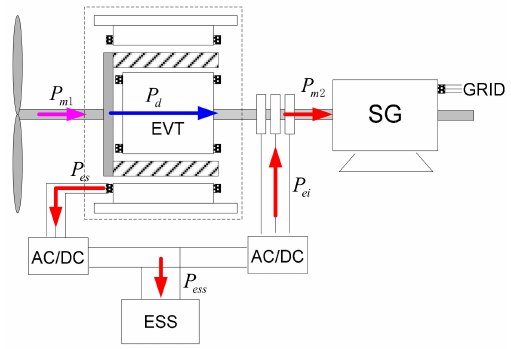
Figure 1. Configuration of the DPF-WECS based on the